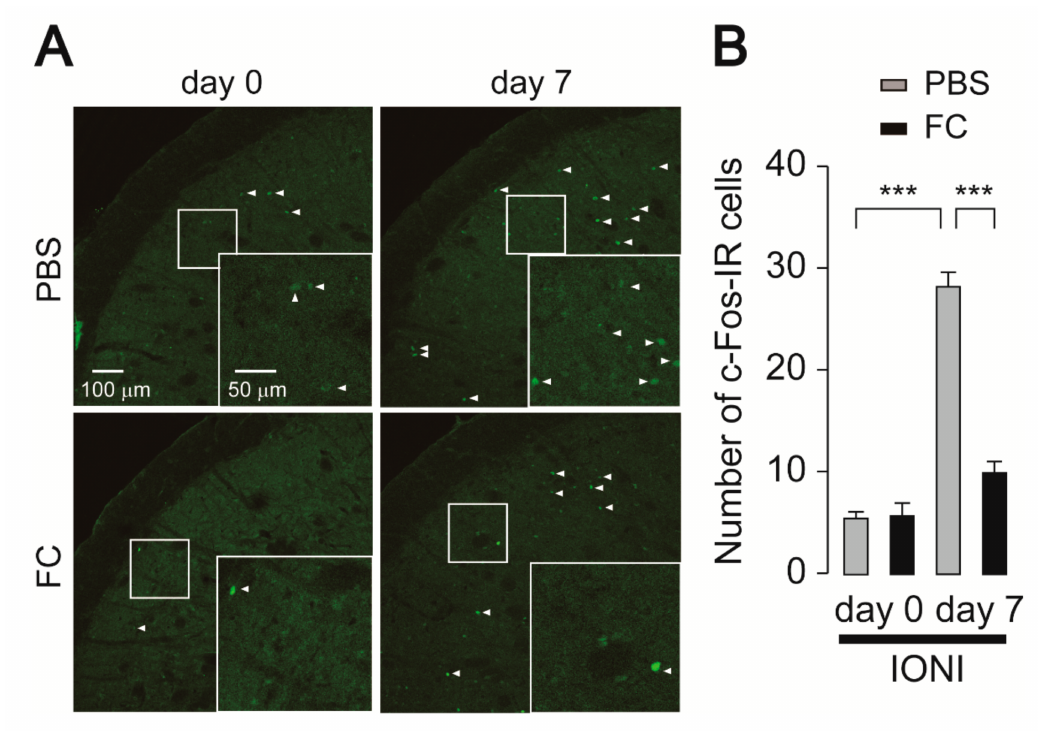
Figure 4. Fluorocitrate attenuates c-Fos expression in the Vc following IONI. ( A ) Representative images of c-Fos immunofluorescence in the Vc. Insets indicate enlarged images of the region indicated in the open square. Arrowheads indicate c-Fos-IR cells. ( B ) The average number of c-Fos-IR cells in the Vc of PBS or fluoroacetate (FC)-treated rats 0 and 7 days after IONI. PBS (day 0): n = 5, FC (day 0): n = 5, PBS (day 7): n = 5, FC (day 7): n = 5, two-way ANOVA followed by Tukey’s multiple comparison test, *** p < 0.001. The data represent the means ±